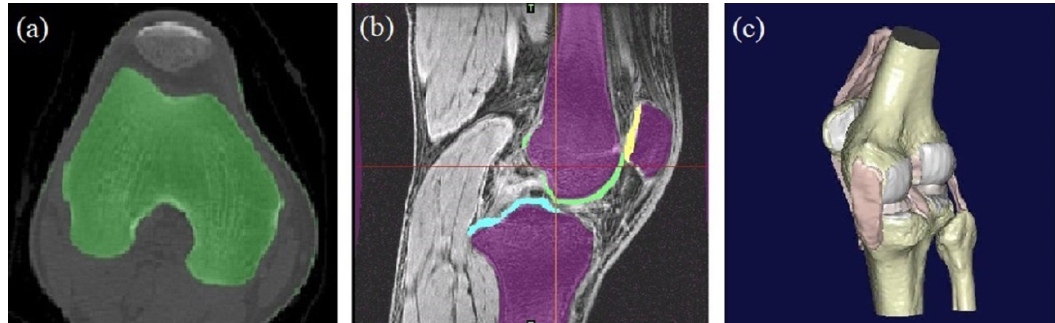
Figure 1. ( a ) Contour tracing of bone from CT; ( b ) MRI image; ( c ) the geometric anatomy model of human knee.